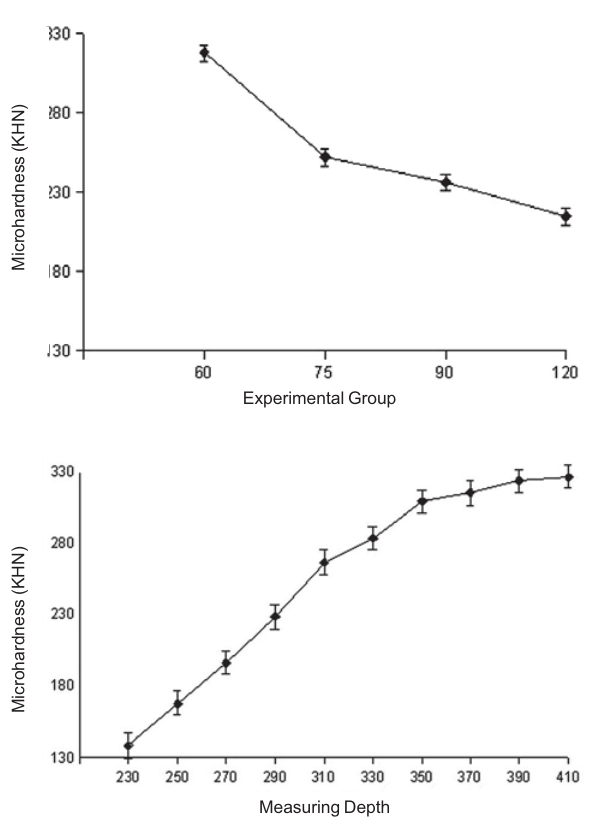
FIGURE 1- Cross-sectional microhardness profiles of the experimental specimens, by group ( upper panel; 60 days , n = 10; 75 days , n = 10; 90 days , n = 9; and 120 days , n = 10) and measuring depth ( lower panel; n = 39). TABLE 1- Phosphorus (P ) and calcium (Ca) mean concentrations before and after demineralizing solution replacement i